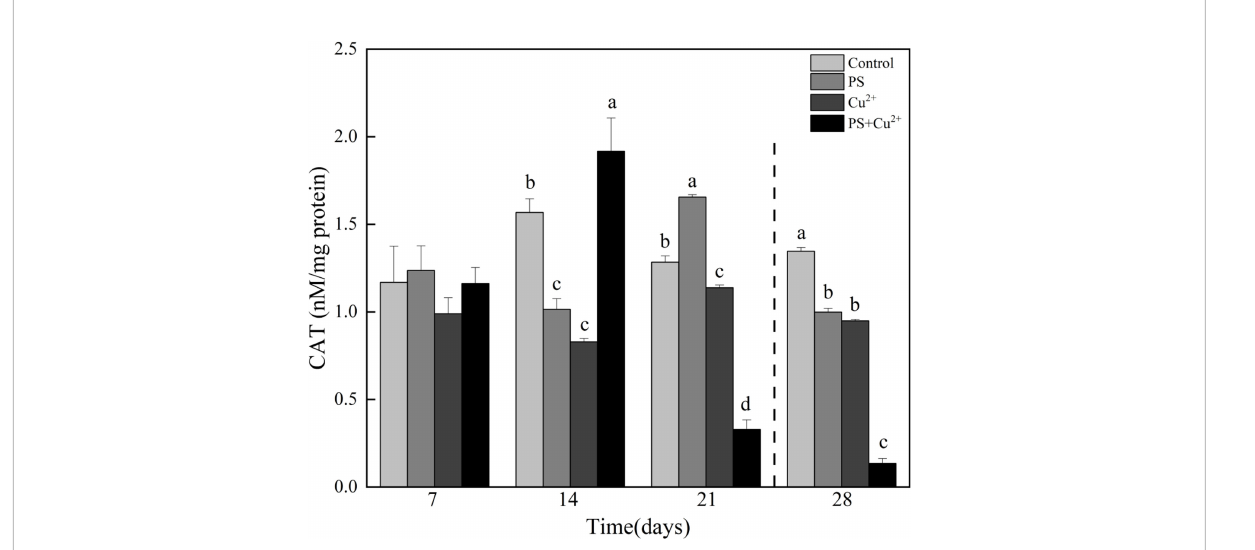
FIGURE 2 Catalase (CAT) activities in whole tissues of Tachypleus tridentatus exposed to 100-nm micro-PS (10 4 particles l -1 ), Cu 2+ (10 µg l -1 ), and a combination of PS and Cu 2+ at days 7, 14, and 21, allowed to recover for 7 days (28 days). Data are shown as mean values ± standard deviations. The superscripts of different lowercase letters indicate signi fi cant differences (p < 0.05) between the four groups.